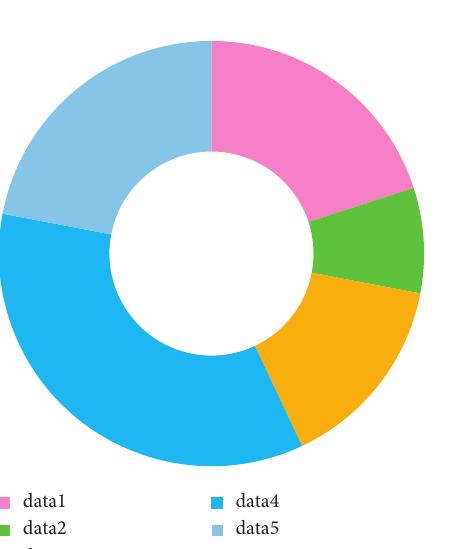
Figure 7: Forecast accuracy of three models.